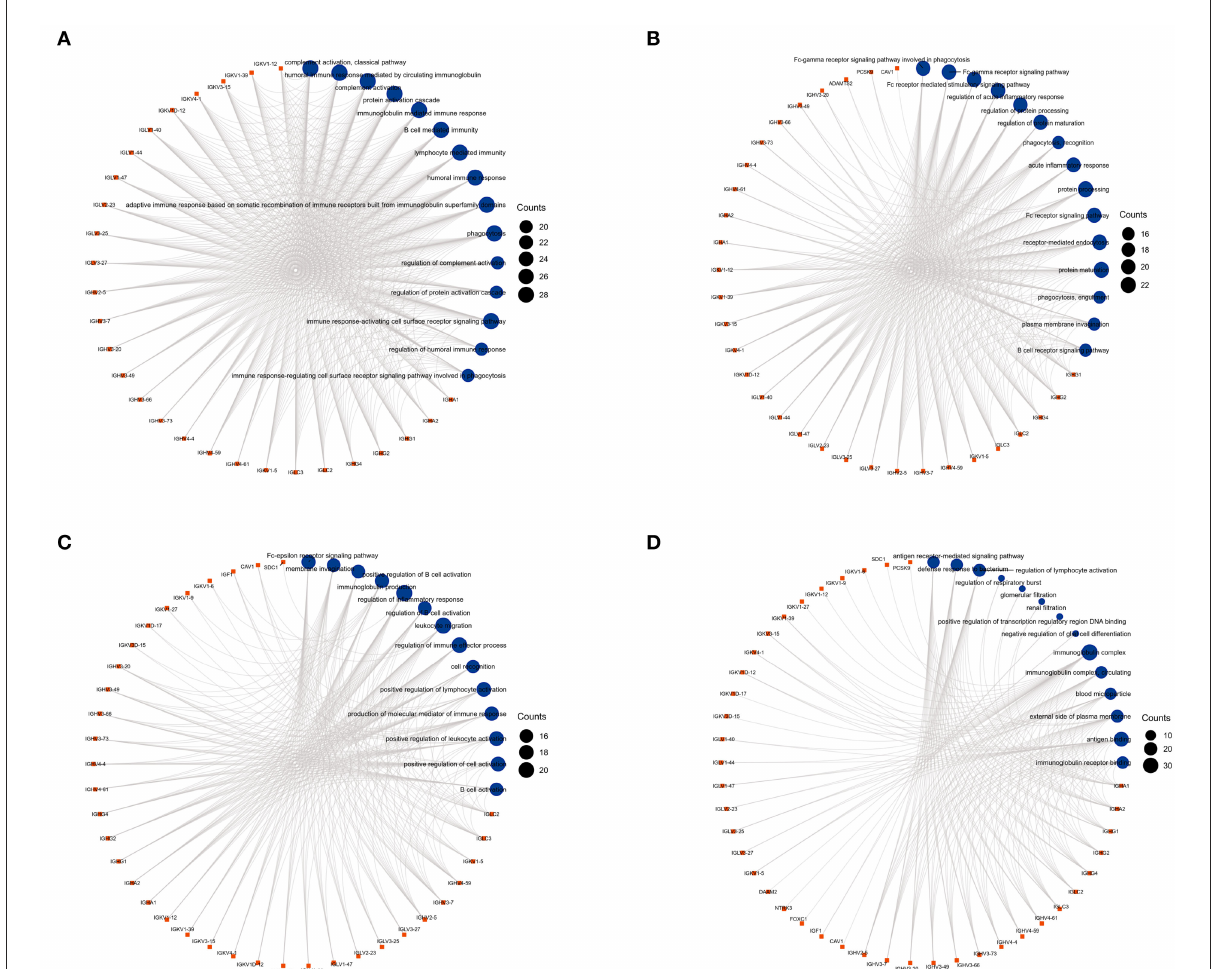
FIGURE4 The circular diagrams of GO analysis of 59 common DEGs. (A–D) Fifty-eight GO terms were enriched. The arcs showed the corresponding relationship between DEGs (in red) and GO terms (in blue) in the GO